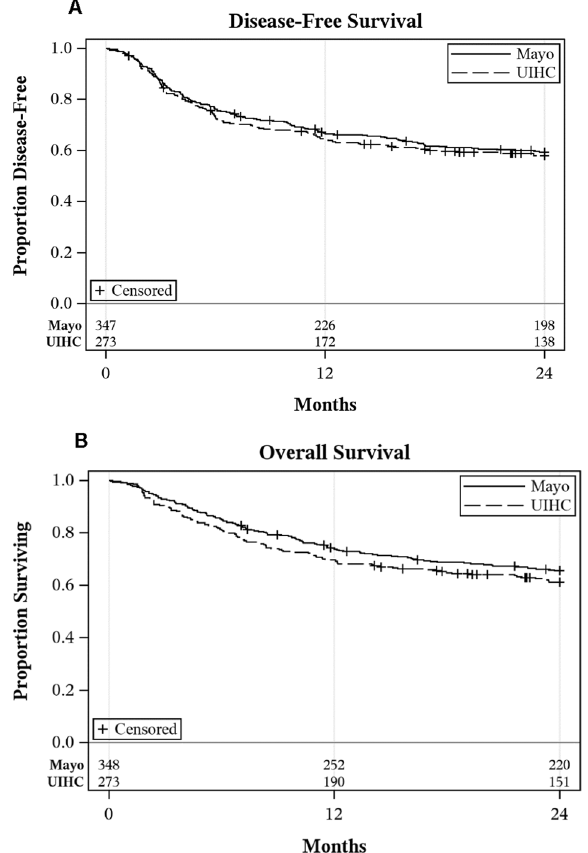
Fig. 1 Two-year disease-free survival and overall survival for the training (UIHC) and testing (Mayo Clinic) cohorts. Figure 1 represents two-year DFS A and two-year OS B for the UIHC and Mayo Clinic cohorts which were 58% and 59%, and 61% and 66%, respectively. Disease-free survival (DFS) is de fi ned as time from the initial allogeneic transplant to relapse or death due to HCT-related causes; overall survival (OS) de fi ned as time from the initial allogeneic transplant to death due to any cause. Patients alive and without relapse at two years were